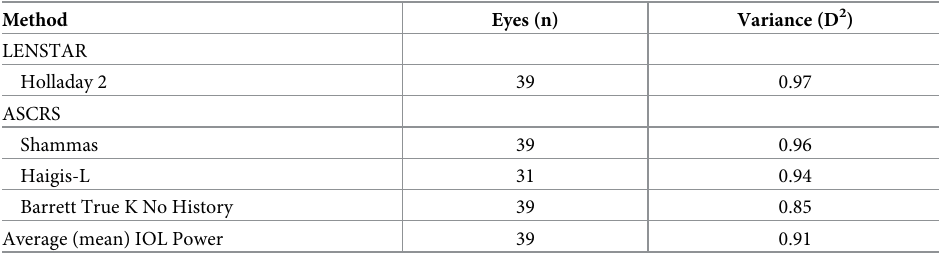
Table 4. Variances in arithmetic IOL prediction errors.